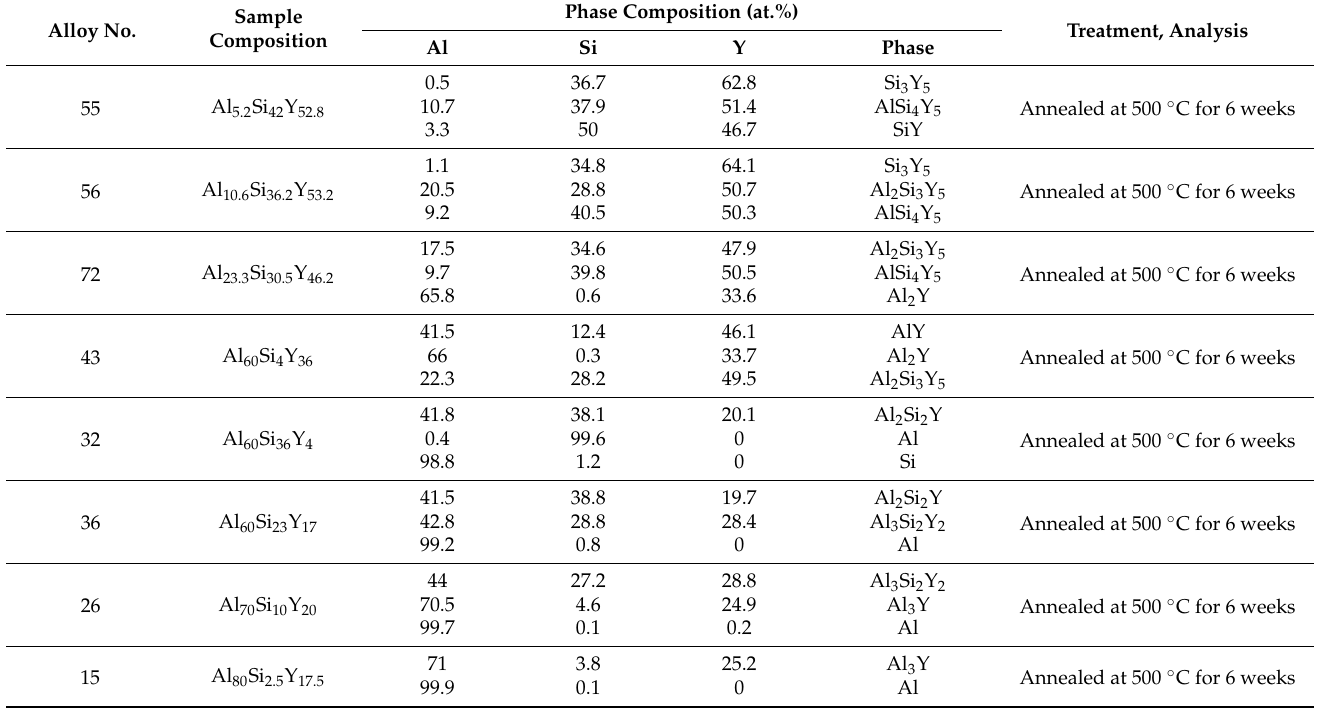
Table 2. Phase analysis results of the EPMA investigation of the representative annealed samples in the Al–Si–Y